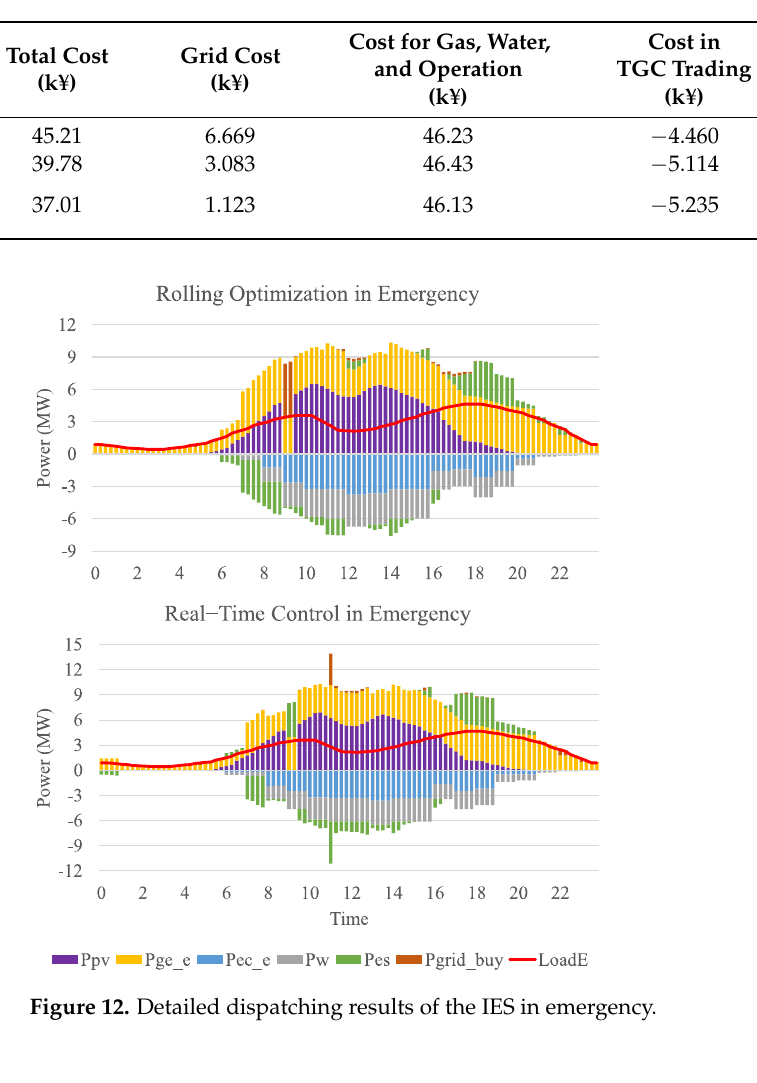
Table 6. Operation Results in Emergency.